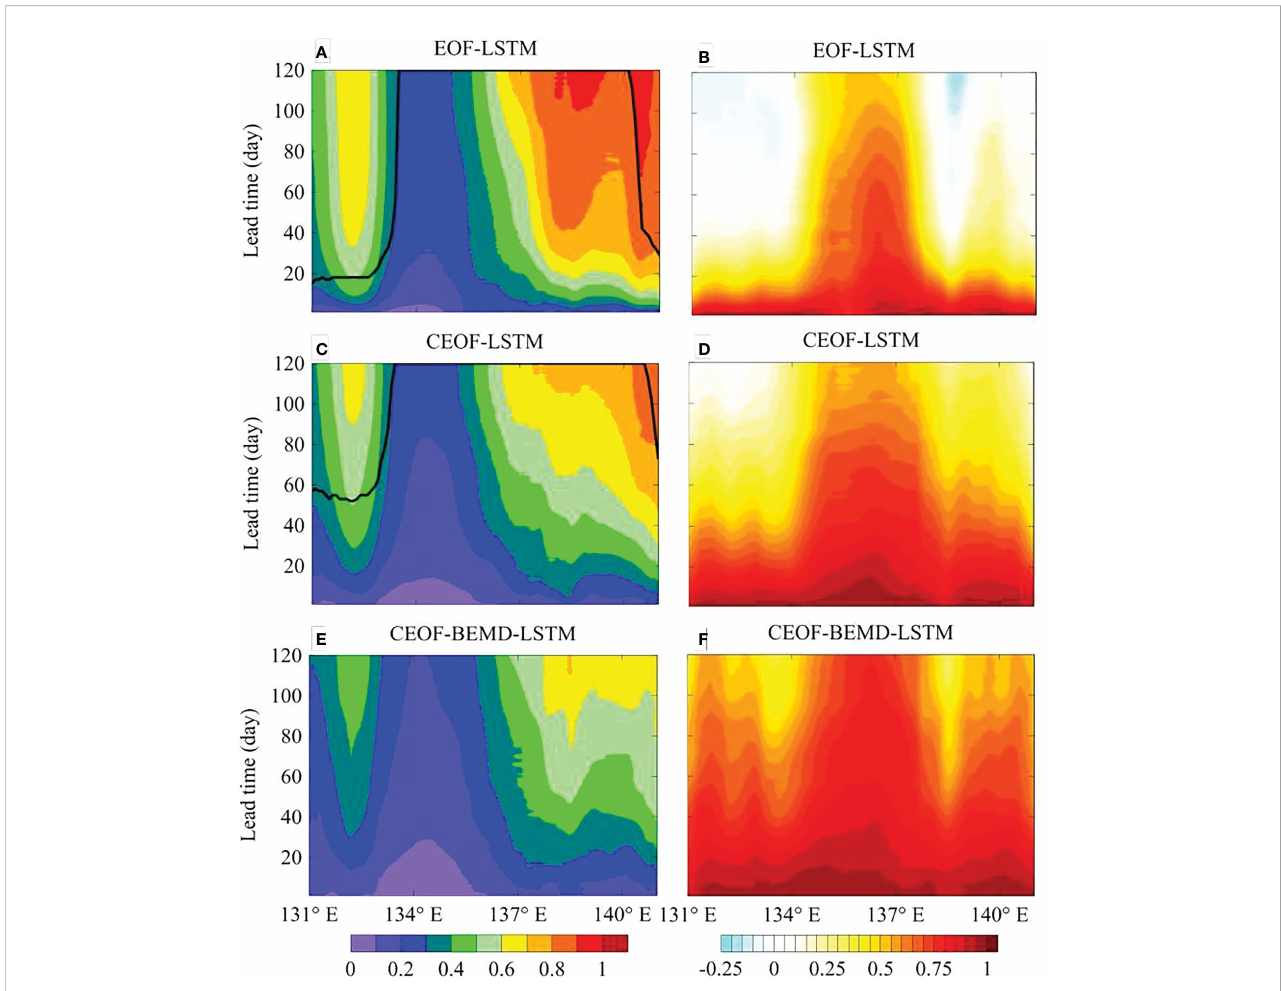
FIGURE 4 Left panels (A, C, E) : Temporal-spatial distributions of RMSE (°) of the 1-120 days Kuroshio path predictions using EOF-LSTM, CEOF-LSTM, and CEOF- BEMD-LSTM models. The solid black contour indicates the prediction range where the RMSE at each location of the Kuroshio path reaches its climatological standard deviation. Right panels (B, D, F) : Same as the left panels, except for temporal-spatial distributions of prediction skill score.